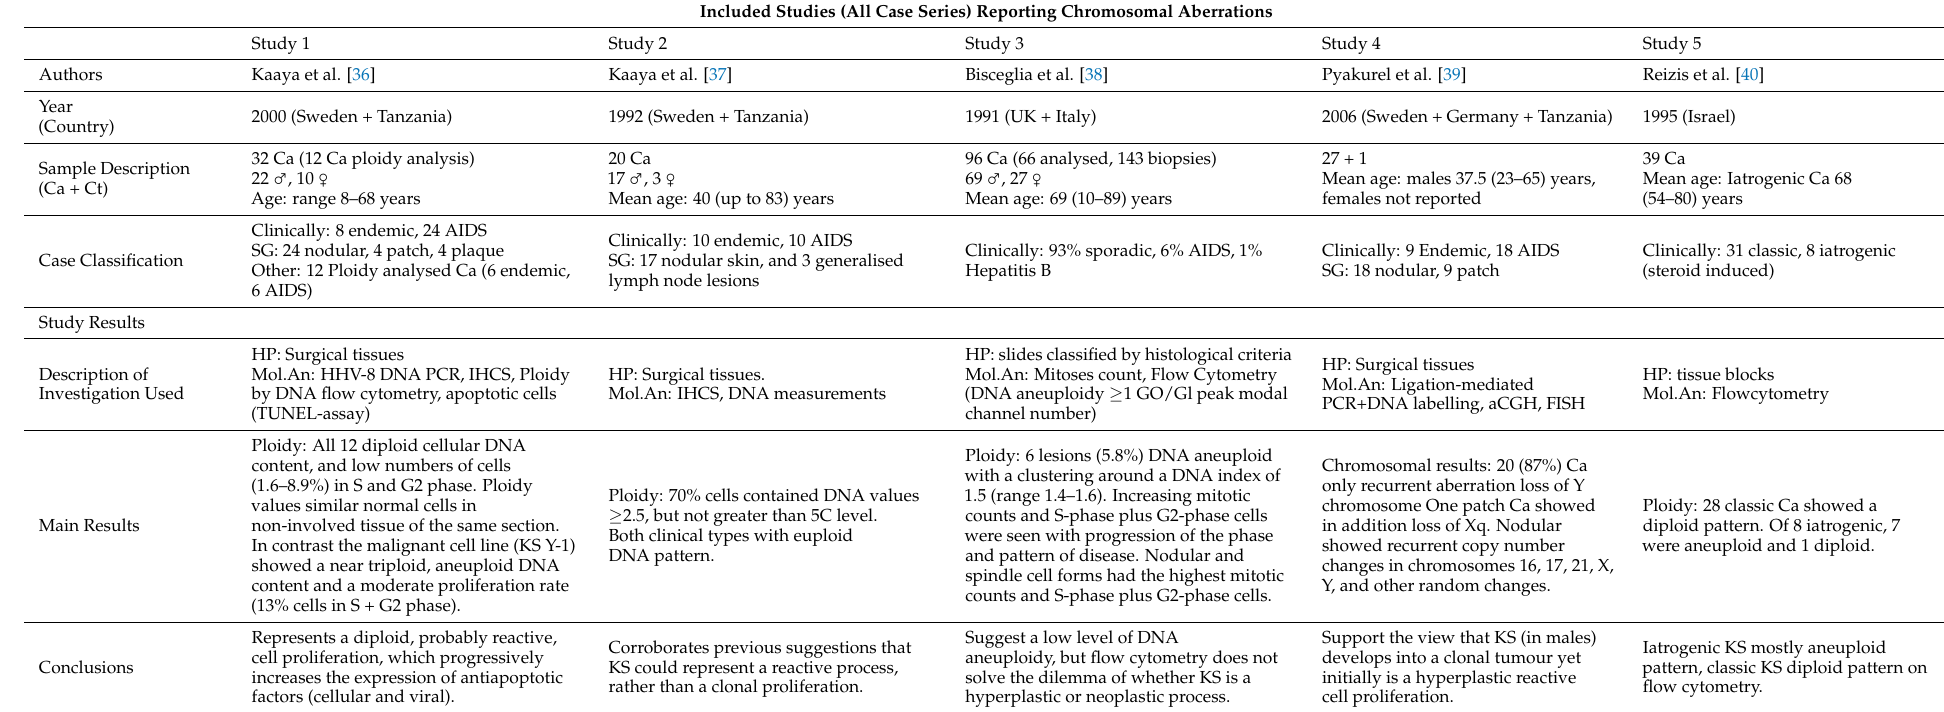
Table 4. Summary of findings: studies reporting on chromosomal